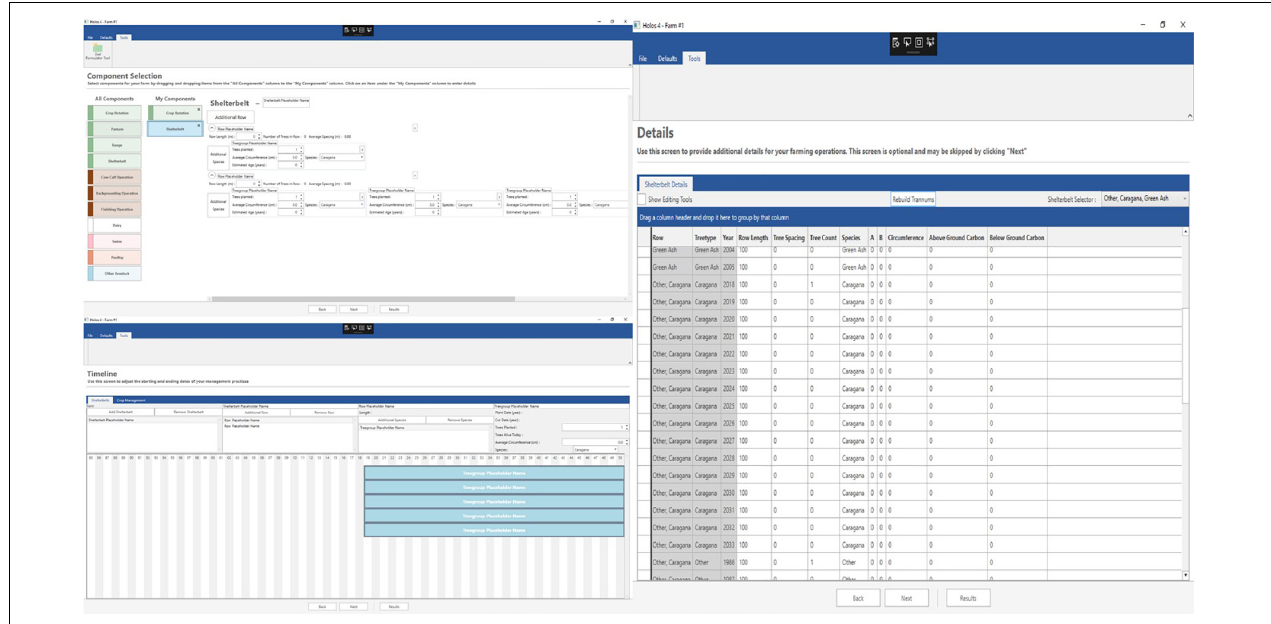
FIGURE 2 | Screenshots of the Holos model interface. TABLE 3 | Coefficients for above-ground biomass estimation for shelterbelt tree species. a b a Diameter (cm) Spacing (m) Mortality (%)